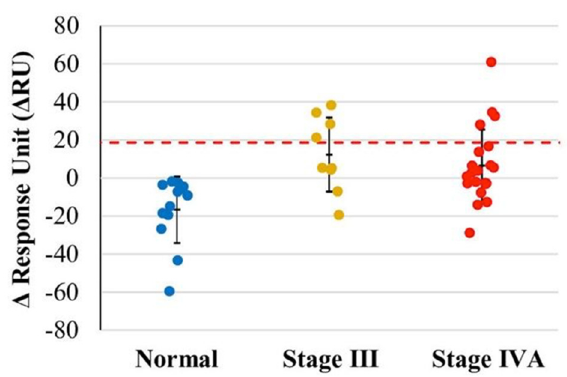
Figure 5. Analysis of normal and oral cancer patients of E6 with anti-HP-1 IgY antibodies. Δ RU values of normal, stage III and stage IV represented by the colors blue, yellow, and red. A total of 26.7% of oral cancer patients (stage III + IV) showed positive results.